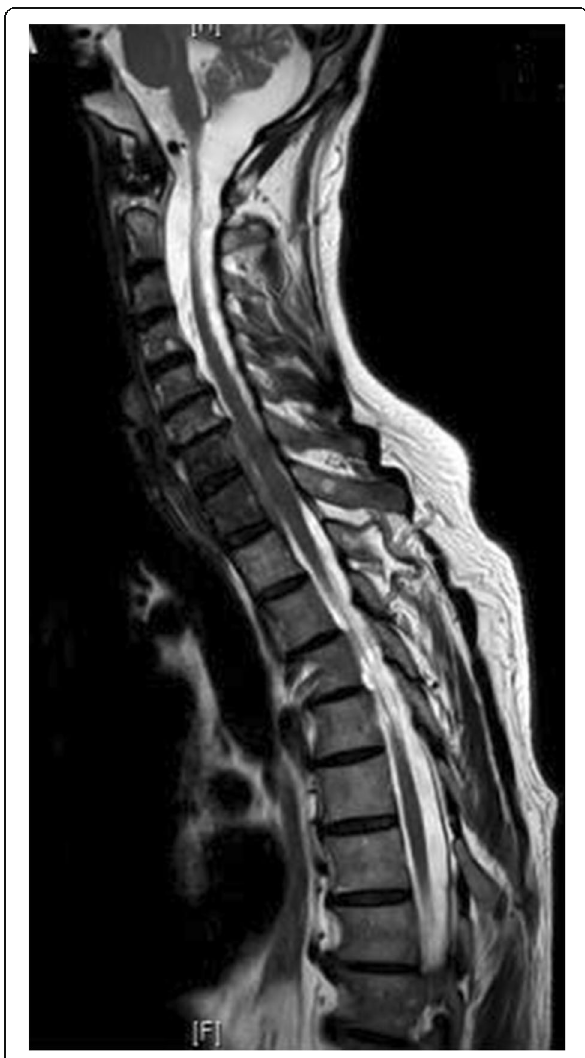
Fig. 2 Sagittal posttreatment MR image of the cervico-thoracic spine, 1 day after surgery, demonstrating persistent enhancement of the C6, C7, and T1 vertebral bodies and complete resolution of the previously identified epidural